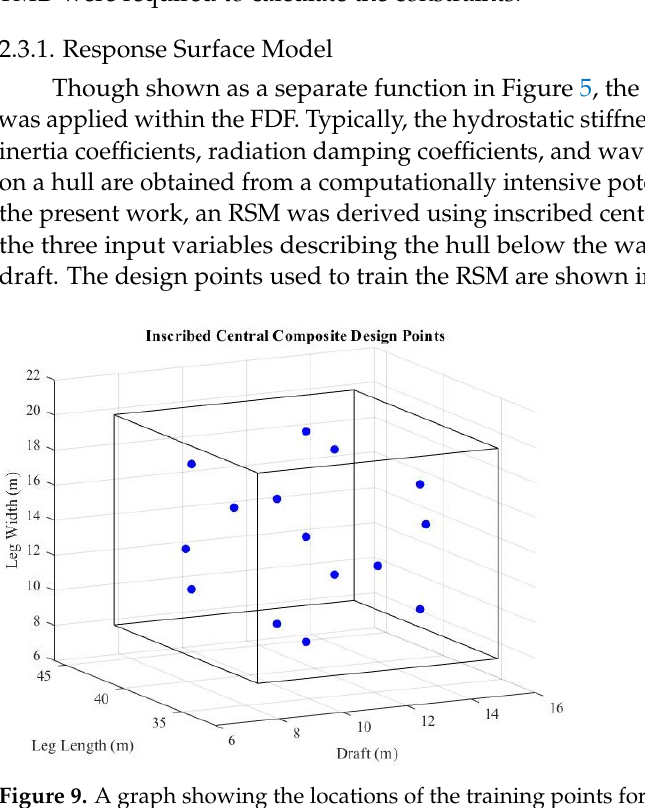
Figure 9. A graph showing the locations of the training points for the